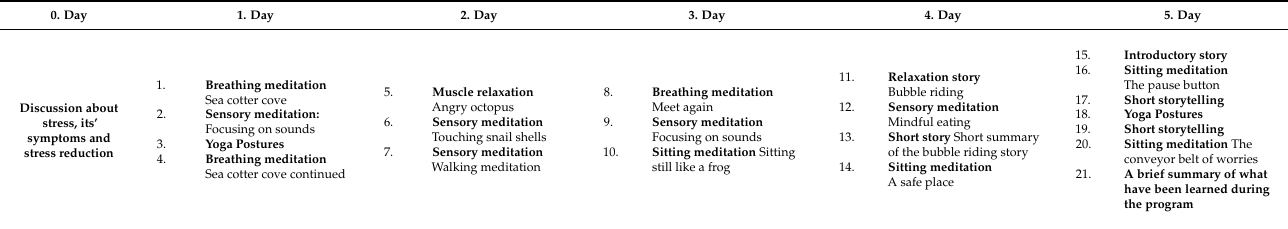
Table 2. Schedule of the